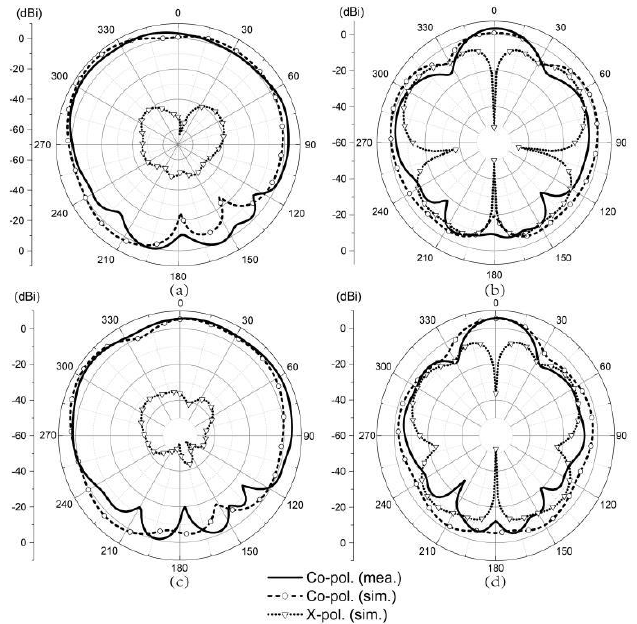
Figure 16. Simulated and measured radiation patterns of array antenna at ( a ) 4.8 GHz, x-z plane, ( b ) 4.8 GHz, y-z plane, ( c ) 5.2 GHz, x-z plane, ( d ) 5.2 GHz, y-z plane.